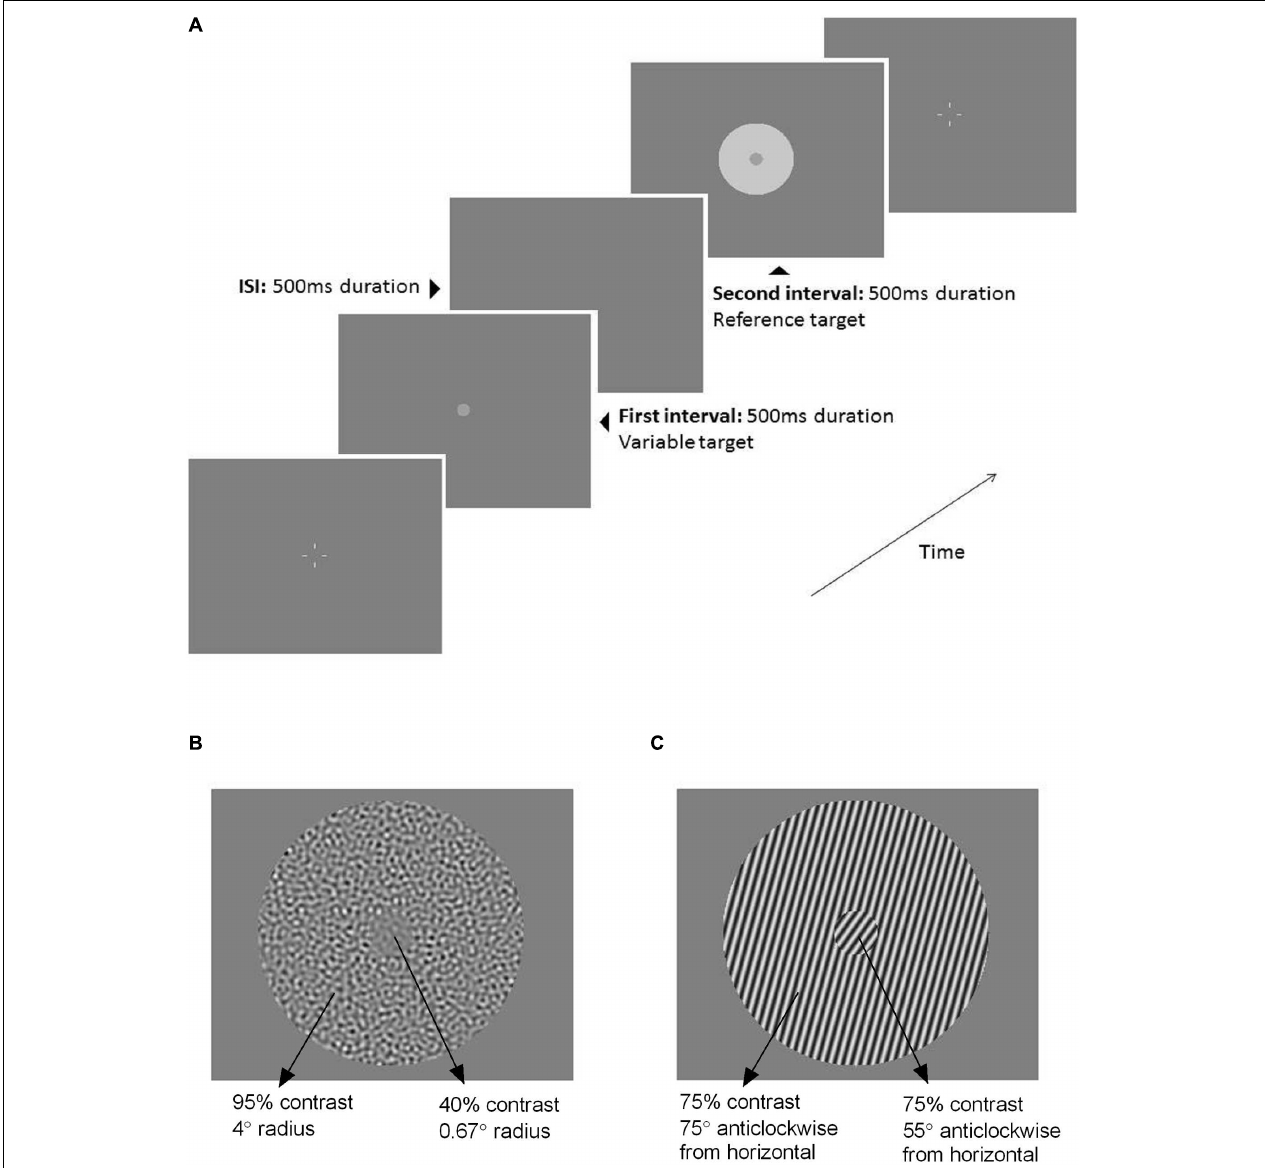
FIGURE 1 | (A) Schematic of the two-interval forced choice (2IFC) procedure used throughout the testing. The first interval (500 ms) contained the variable target (0.67 ◦ radius) with no surround. The second interval (500 ms) contained the fixed, reference target that was either presented without a surround (‘no surround’ condition), or with a surround as depicted here (‘surround’ condition, 4 ◦ radius annulus). The interstimulus interval was 500 ms. Four white nonius lines appeared before and after each trial to assist with central fixation. The stimulus shown here is an example of the luminance task. Example ‘surround’ stimuli for the (B) contrast task and (C) orientation